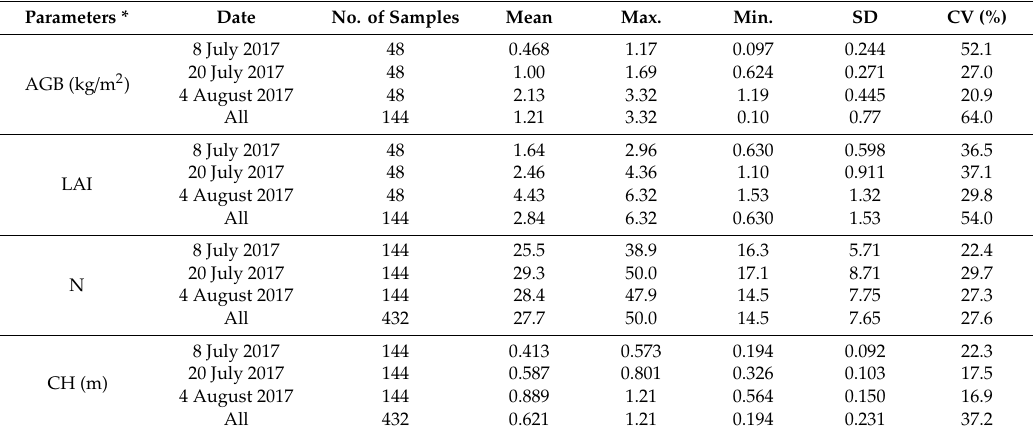
Table 1. Summary statistics of measured leaf area index (LAI), aboveground biomass (AGB), and nitrogen concentration (N) and canopy height (CH)